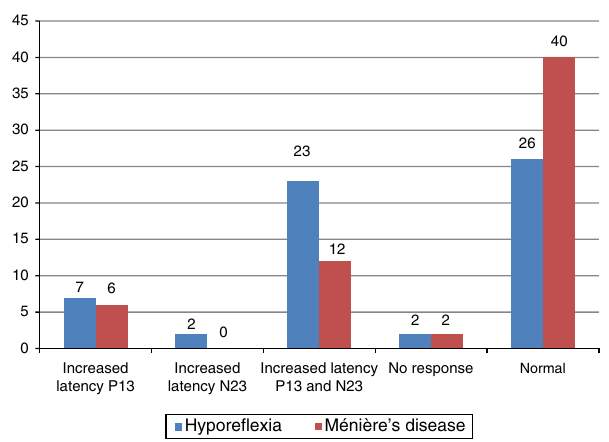
Figure 2 Frequency distribution of the results of cervical VEMP, per ear, for individuals with vestibular hyporeflexia and for individuals with Ménière’s disease ( n = 60).